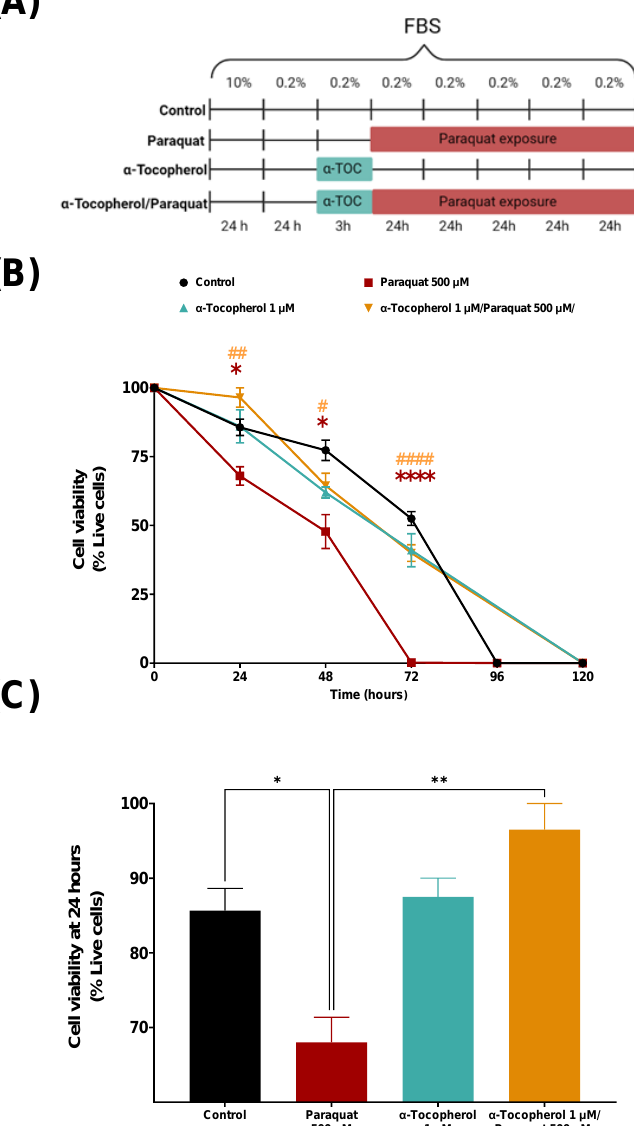
Figure 1. Effects of Paraquat on 1321N1 cells viability with or without pre- treatment with α -tocopherol. ( A ) Time course and design of treatments for the evaluation of cell culture viability. ( B ) Time course of cell viability in control conditions and after treatment with Paraquat (500 µM) with or without a pre- treatment with α -tocopherol (1 µM). Measurements were performed every 24 h using trypan blue cell viability assay. Asterisks symbols (*) refer to post-hoc comparisons with respect to control; hash symbols (#) refer to comparisons with respect to Paraquat. Colour of symbols allude to the condition been compared. ( C ) Cell viability results at 24 h expressed as percentage of live cells. Shapiro-Wilk test was performed to check the normality of distributions. One-way ANOVA analysis (two-tailed) and Tukey post-hoc were conducted , α set to 0.05. p -value < 0.05 (*), p -value < 0.01 (**), p -value < 0.0001 (****), moreover, p- value <0.05 (#), p -value < 0.01 (##), p- value < 0.0001 (####). Differences were observed at 24, 48, and 72 h between the Paraquat-treated and con- trol situations and between the Paraquat- treated cells with or without α -tocopherol pre-